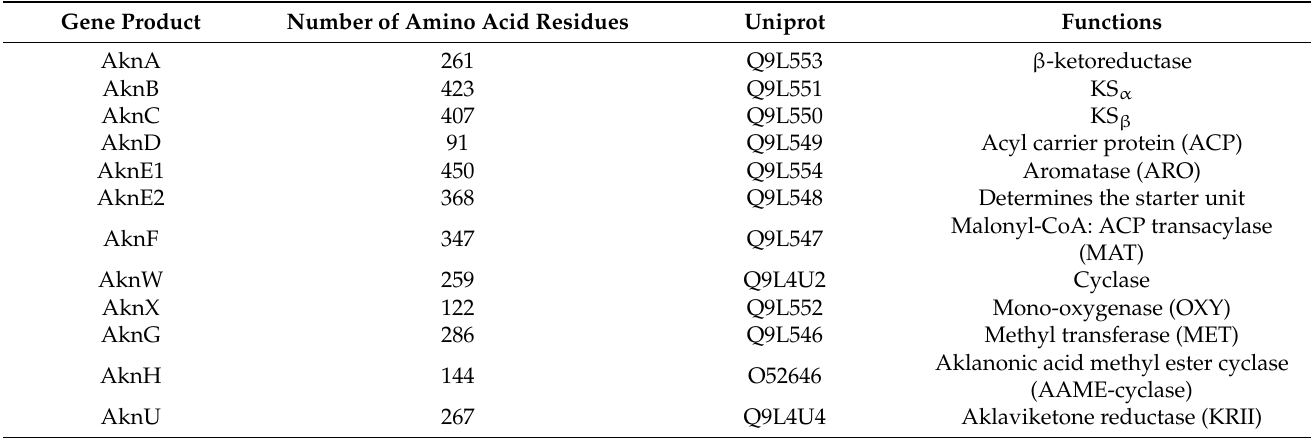
Table 1. The identified and putative functions of the akn genes.